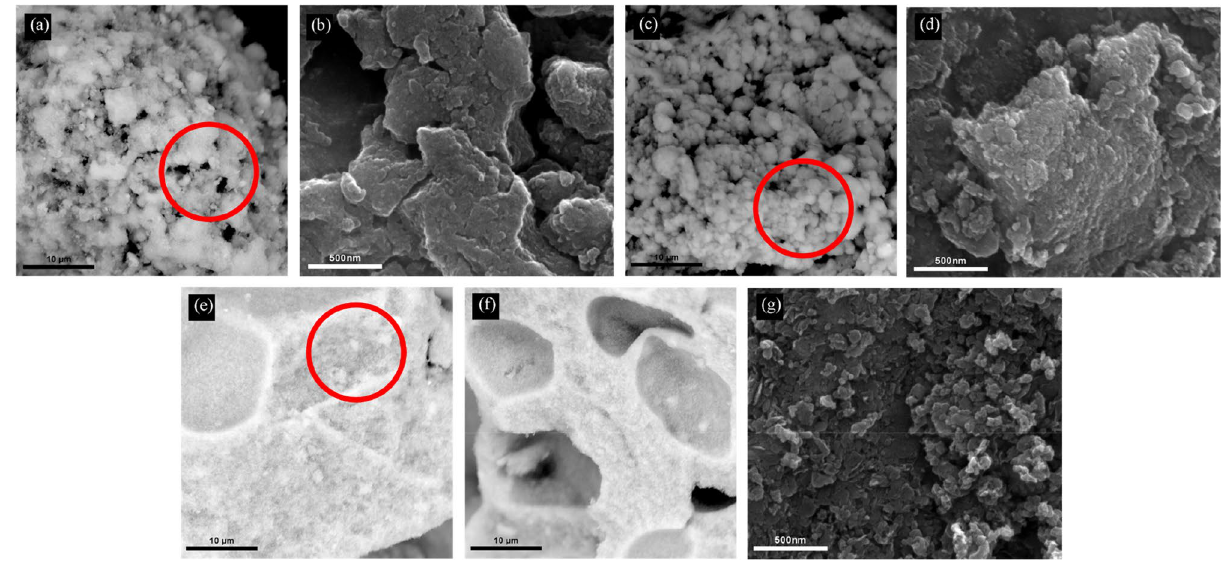
Figure 1. FESEM images of the nanocarbon synthesized for ( a , b ) 10 min, ( c , d ) 15 min, and ( e – g ) 20 min at 7,000X and 15,000X